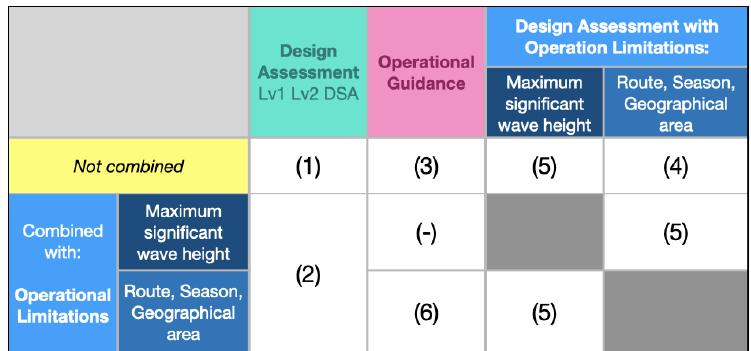
Figure 4. Summary table of each possible configuration of Operational Measure (OM). (1) Unrestricted operation; (2) Limited operation; (3) operation using onboard OG; (4) operation in a specified area or in a specified route during a specified season; (5) limited operation in a specified area or in a specified route during a specified season; (6) operation using onboard OG in a specified area or in a specified route during a specified